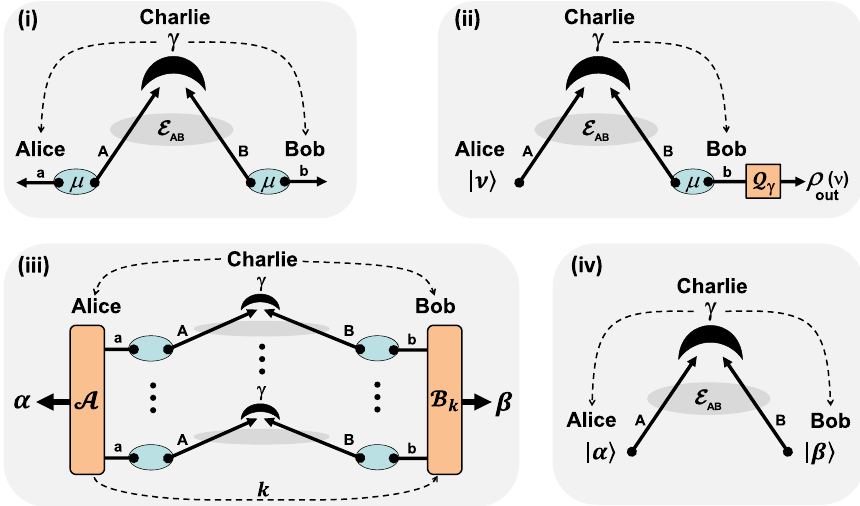
Fig. 3 Relay-based quantum protocols in a correlated Gaussian environment. i Entanglement swapping. Alice and Bob possess two TMSV states with variance μ . Modes A and B are sent through the joint channel E AB and received by Charlie. After the outcome γ is broadcast, the remote modes, a and b , are projected into a conditional state ρ ab ∣ γ . ii Quantum teleportation . Alice ’ s coherent state ν j i is teleported into Bob ’ s state ρ out ( ν ), after the communication of γ and the action of a conditional quantum operation Q γ . iii Entanglement/key distillation . In the limit of many uses of the relay, Alice performs a quantum instrument on her modes a , communicating a classical variable k to Bob, who performs a conditional quantum operation on his modes b . This is a non-Gaussian quantum repeater where entanglement swapping is followed by optimal one-way distillation. iv Practical QKD . Alice and Bob prepare Gaussian-modulated coherent states to be sent to Charlie. The communication of the outcome γ creates remote classical correlations which are used to extract a secret key. Here the role of Charlie could be played by Eve, so that the relay becomes an MDI-QKD